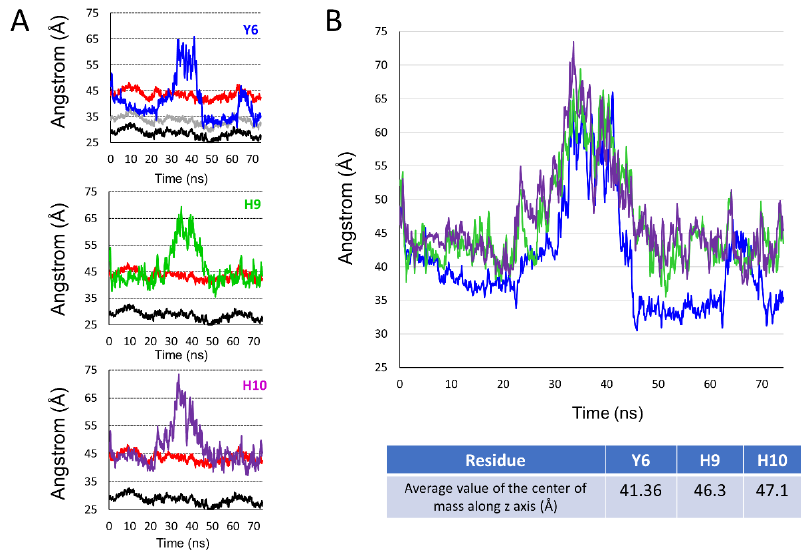
Figure 4. ( A ) Set of plots showing the center of mass over the time along the z-axis for Y6 (blue line, top plot), H9 (green line, mid plot), and H10 (purple line, bottom plot) compared to the average of maximum value over time along the z-axis for sialic acid (red line, all plots), glucose (gray line, top plot), and the ceramide part of GM1 molecules (black line, all plots). ( B ) Plot showing the center of mass along the z-axis over time for Y6 (blue line), H9 (green line), and H10 (purple line) and table below the plot showing the average value of the center of mass along the z-axis for each aromatic residue.